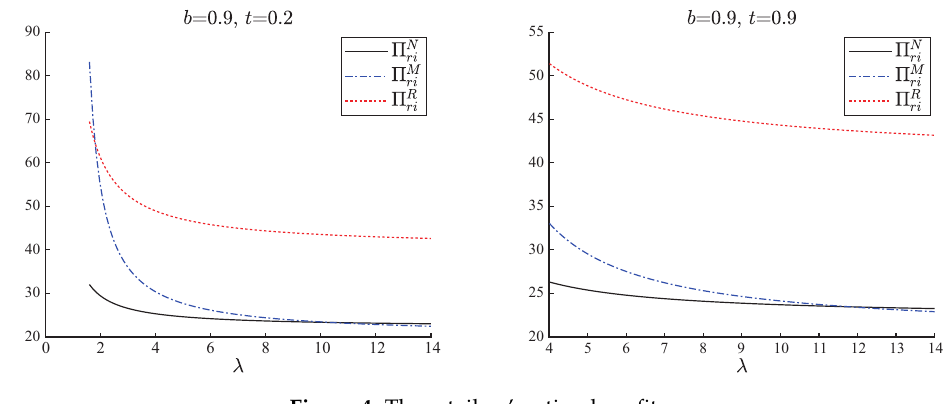
Figure 4. The retailers’ optimal profits.